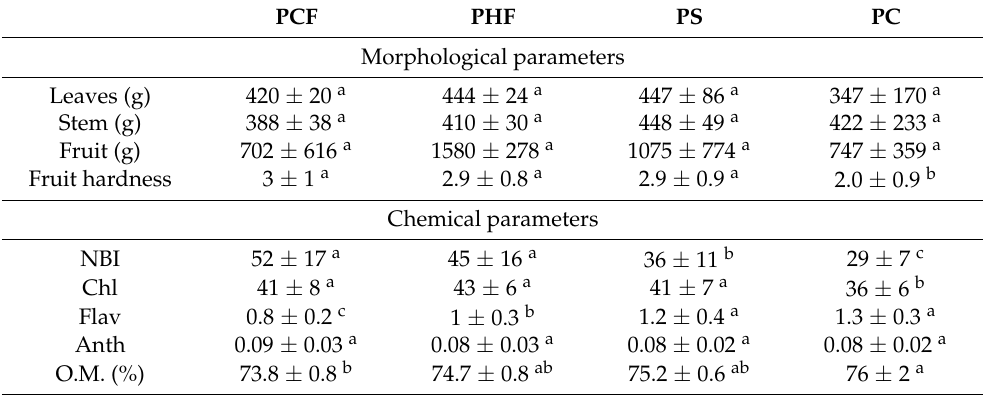
Table 6. Plant growth values of parts weights, fruit hardness, Dualex parameters of Nitrogen Balance Index (NBI), clorophylls (Chl), flavonols (Flav) and anthocyanins (Anth) and organic matter percentage of pepper plants grown in commercial greenhouses in the C soil (PC) and S soil (PS) and with different solutions PCF (conventional treatment) and PHF (plants with an MCT ® treatment). Data are presented as the mean ± standard deviation. Different letters indicate significant differences between treatments ( n = 4; Duncan’s test, p <